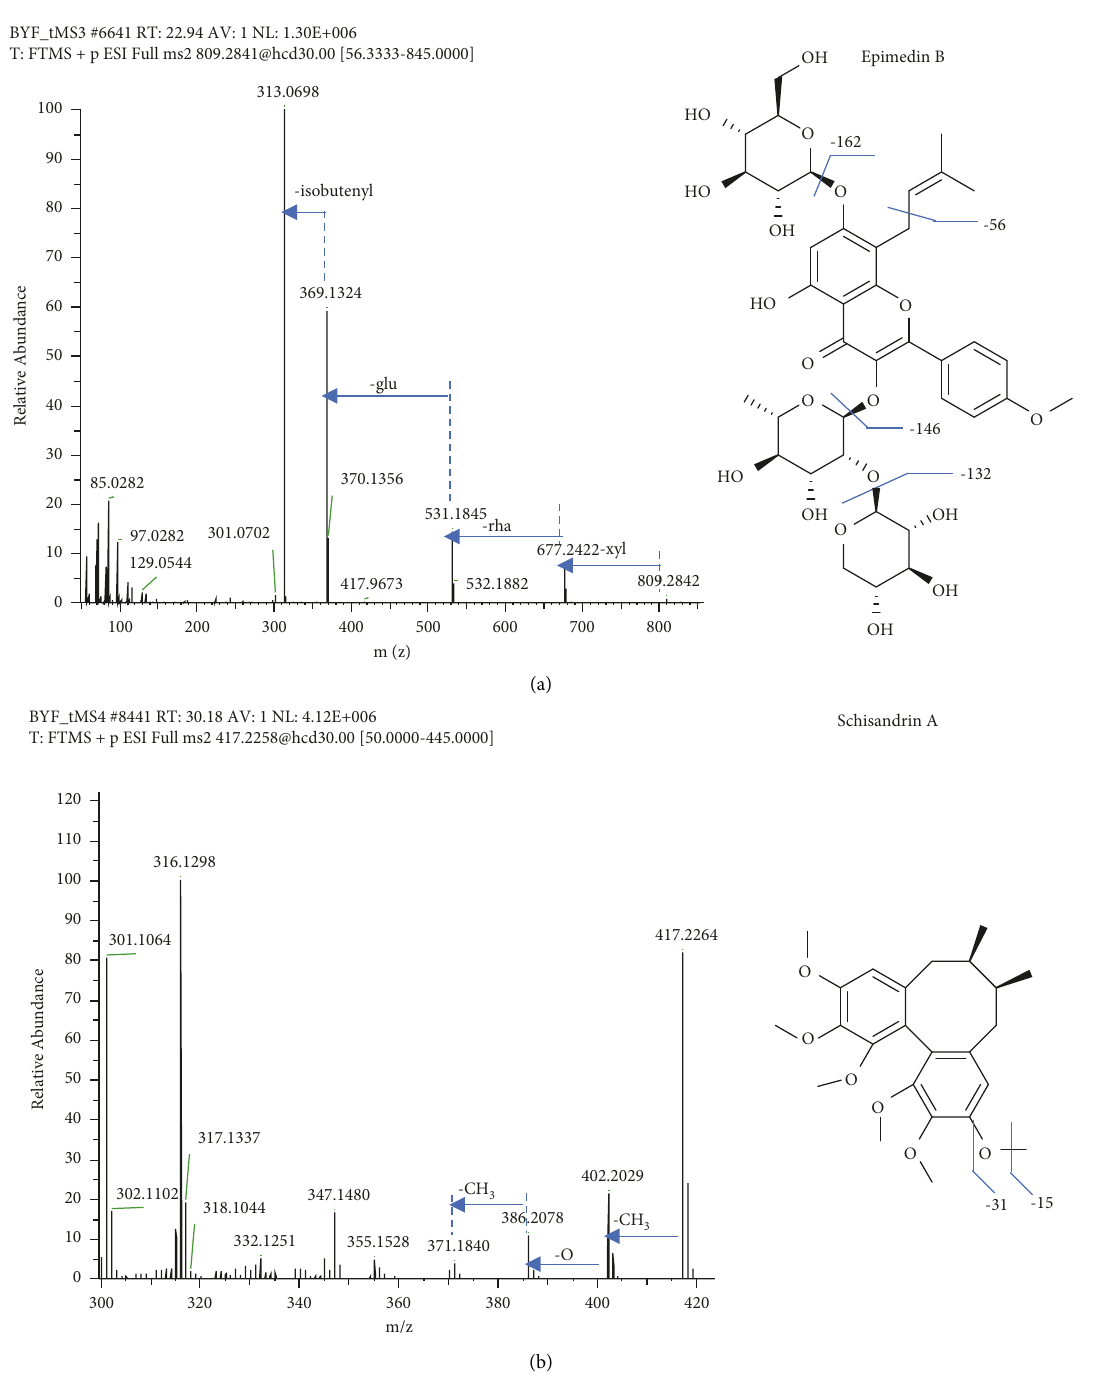
Figure 3: MS/MS spectra and structure of epimedin B (a) and schisandrin A